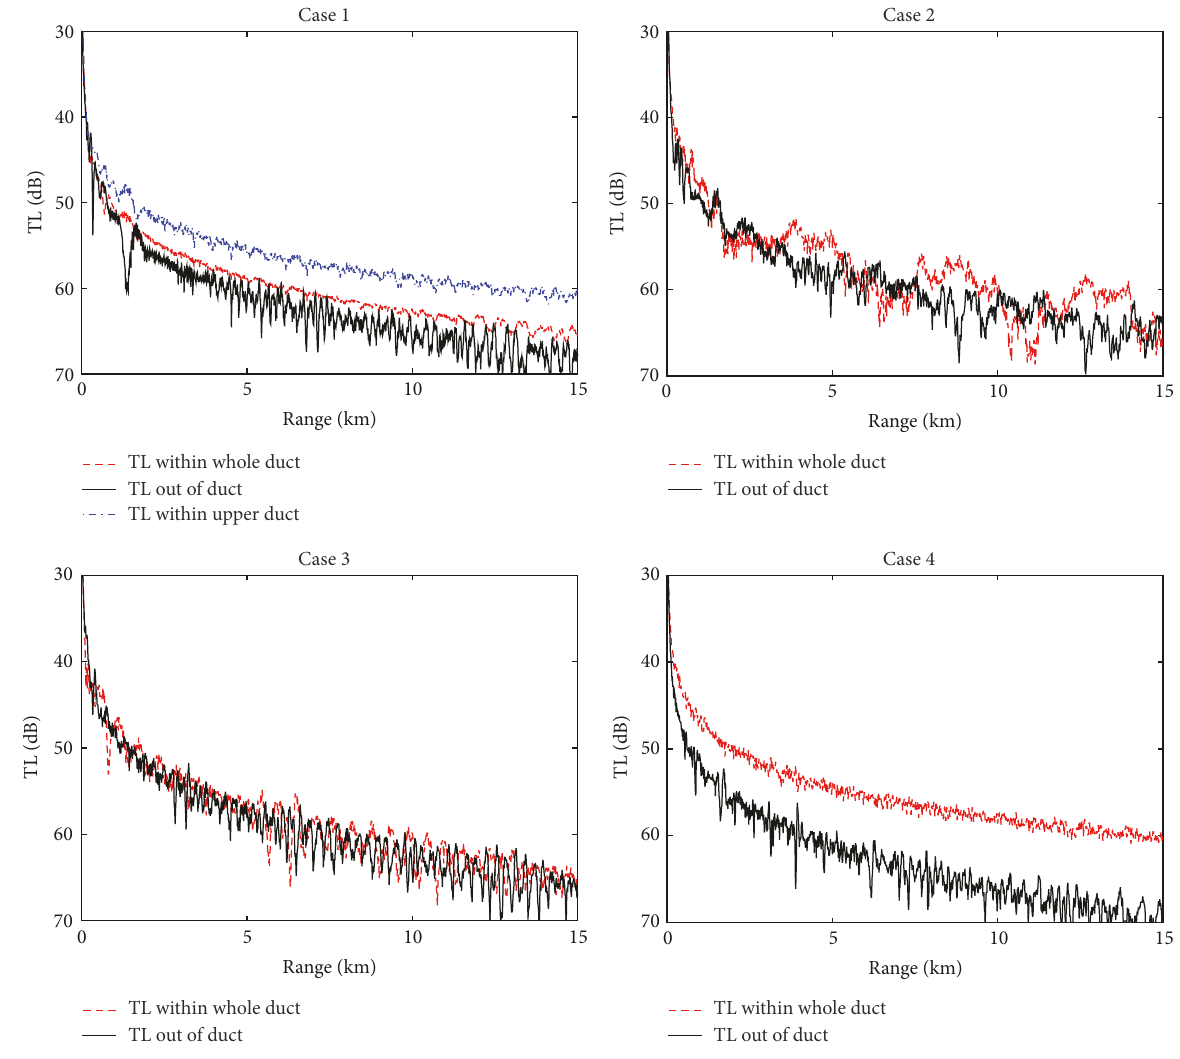
Figure 11: Depth-average TLs for different